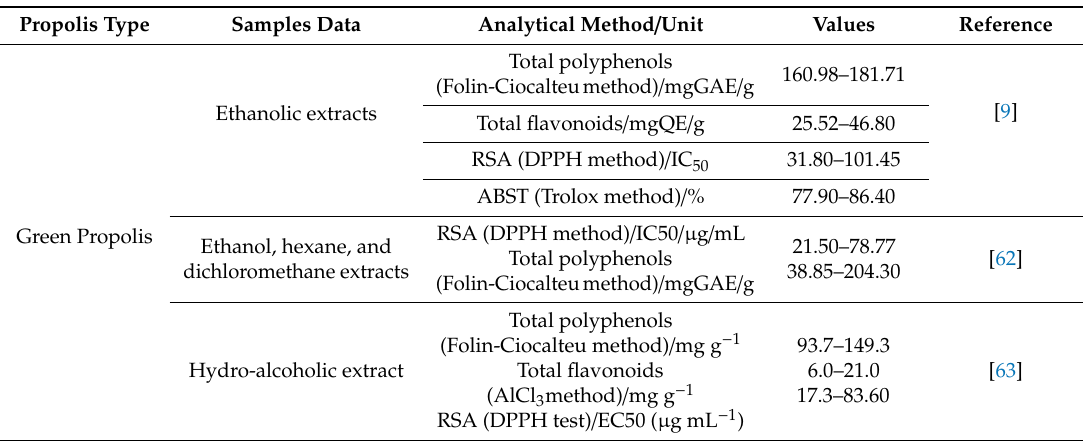
Table 1. Total polyphenolic and flavonoid content and antioxidant activity of red and green Brazilian